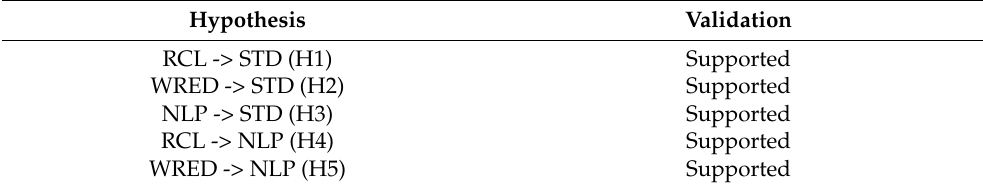
Table 6. Hypotheses’ validation.